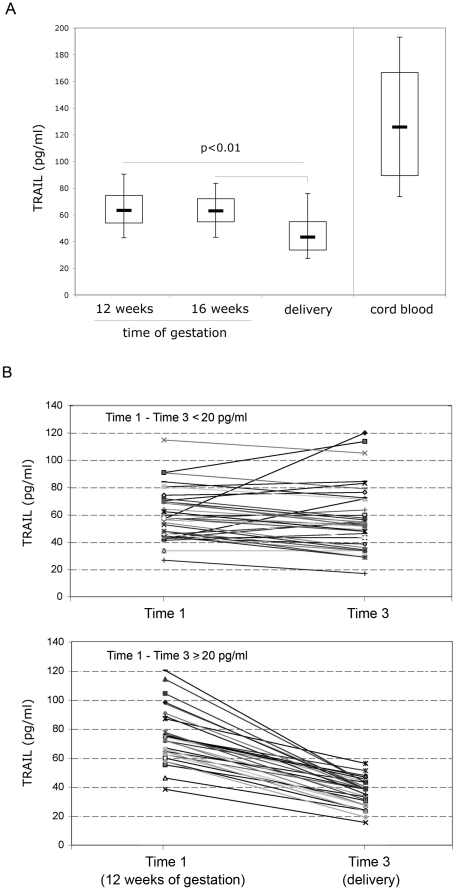
Serum TRAIL levels during pregnancy and in the corresponding cord blood.In A, levels of TRAIL were determined by ELISA in sera from 73 pregnant women (analyzed at the indicated times of gestation and at delivery) and from the corresponding cord blood. Horizontal bars are median, upper and lower edges of box are 75th and 25th percentiles, lines extending from box are 10th and 90th percentiles. In B, two groups of women enrolled in this study were identified on the basis of the drop in the TRAIL serum levels between 12 weeks of gestation (time 1) and delivery (time 3) <20 pg/ml (group 1) or ≥20 pg/ml (group 2). Individual values for each of the 73 women are shown at time 1 and time 3.